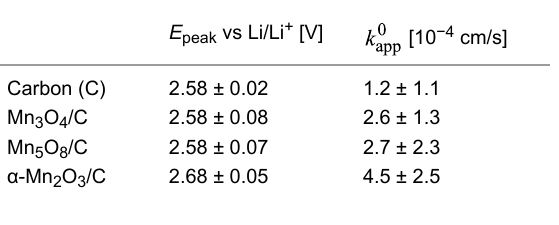
Table 2: ORR potentials and reaction rate constants obtained from the linear sweep measurements recorded at ν = 50 mV/s.